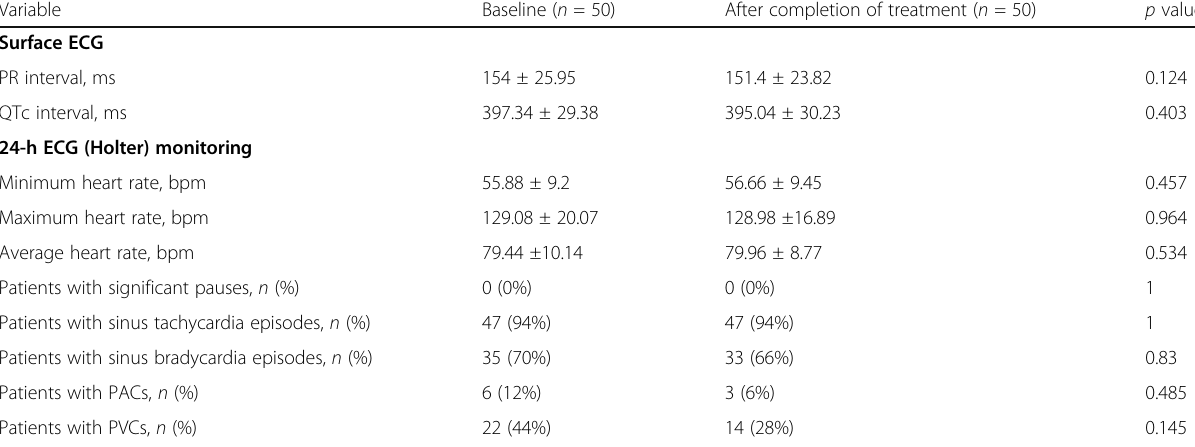
Table 1 Comparing surface ECG and Holter monitoring variables at baseline and after completion of treatment Variable Baseline ( n = 50)